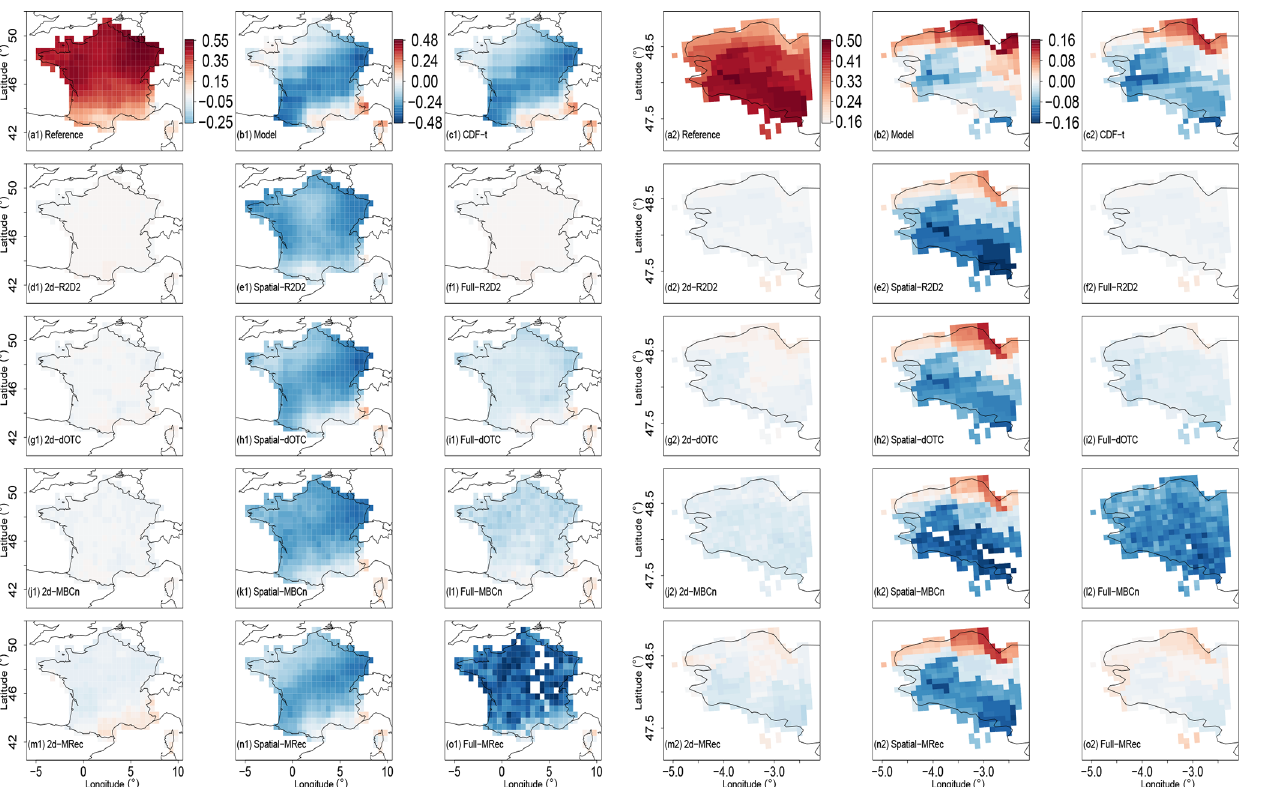
Figure 2. Differences of temperature vs. precipitation Spearman correlation computed at each grid cell for BC methods using (a1– o1) WFDEI reference and (a2–o2) SAFRAN reference during winter over the 1979–2016 period. Results are shown for reference, plain IPSL, CDF-t, R 2 D 2 , dOTC, MBC-n and MRec outputs for 2d-, Spatial- and Full- versions. Note that the color scales between panels (a1) – (o1) and (a2) – (o2) are not the same to better emphasize intensities of values in the two